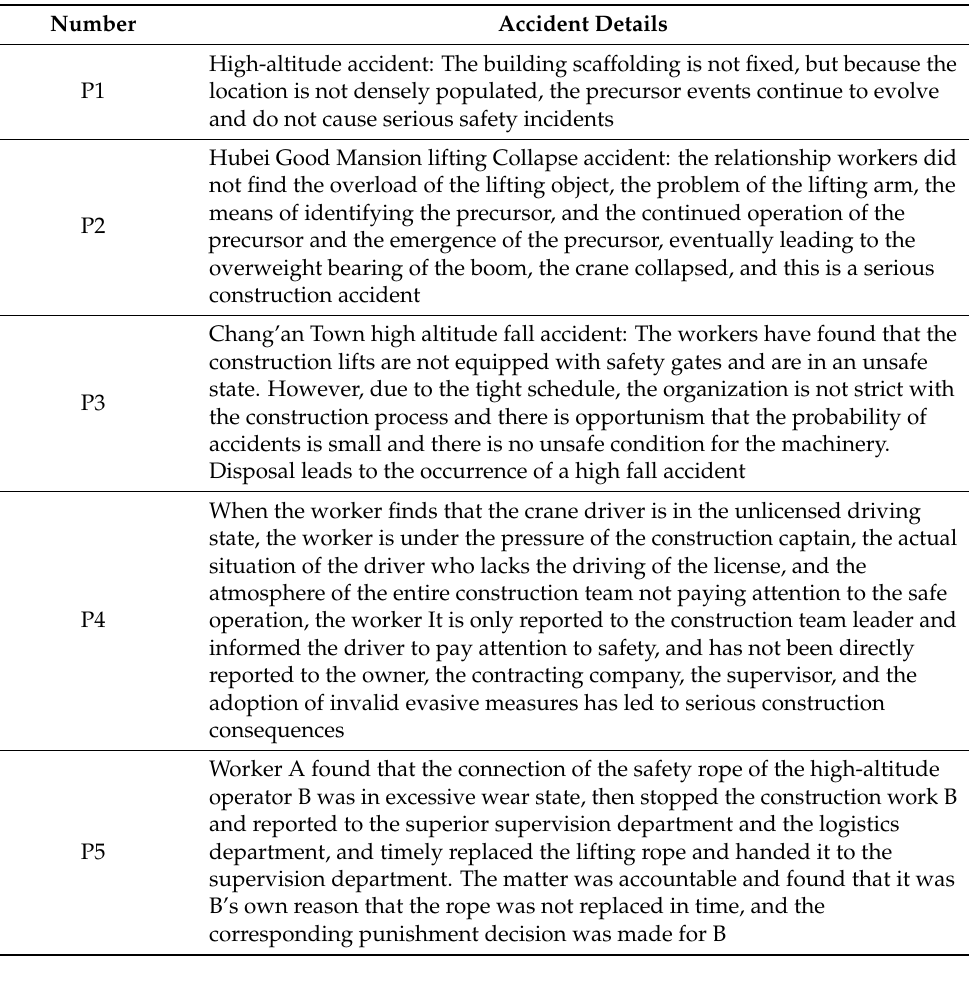
Table 5. Five typical construction accidents.